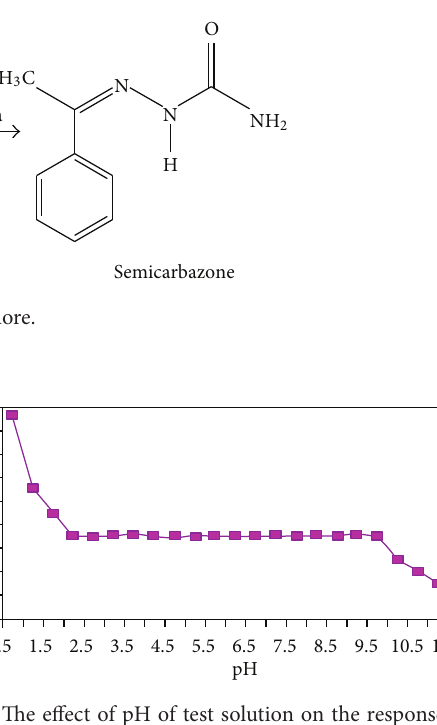
F 3: e effect of pH of test solution on the response of the ion selective Mg 2+